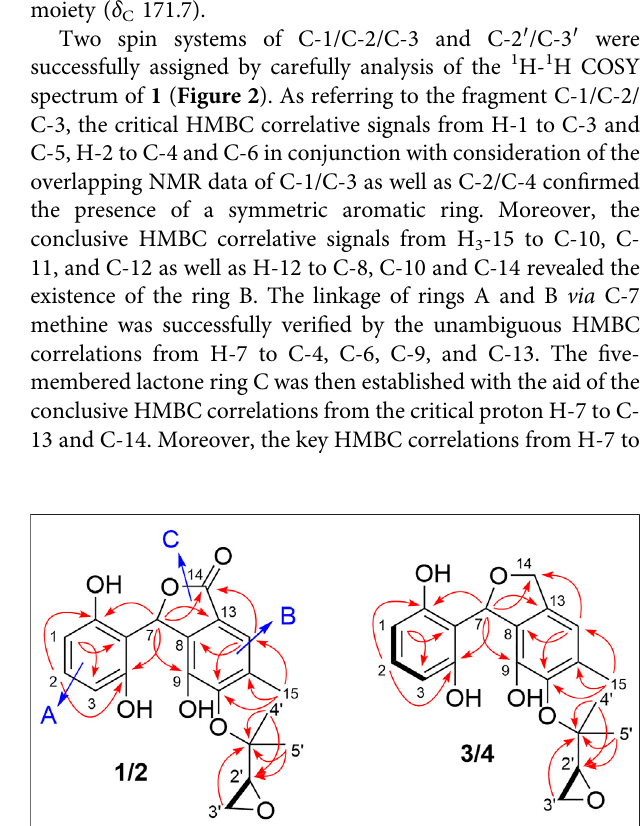
FIGURE 2 | 1 H- 1 H COSYs and key HMBCs of 1-4